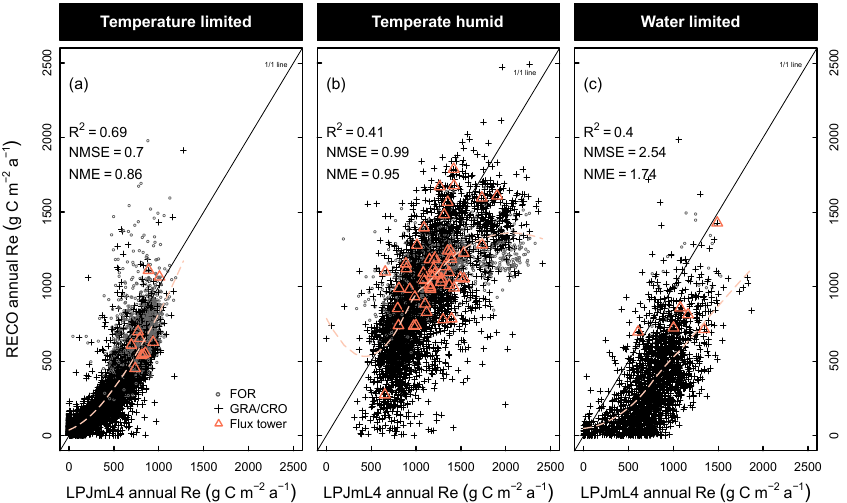
Figure 6. Ecosystem respiration ( R e ) evaluation of standard LPJmL4 simulations with satellite-derived estimations from Jägermeyr et al. (2014). Annual R e sums for all pixels from the displayed extent in Fig. S70 are compared and separated by climate type (a) – (c) . Dashed lines indicate a polynomial bias curve. Chart symbols are separated for forest (FOR) and grassland–cropland (GRA–CRO) land cover